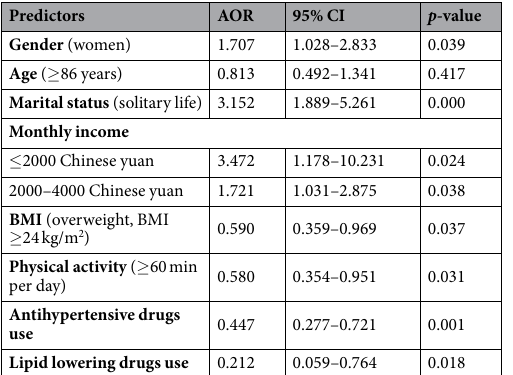
Table 2. Adjusted odds ratio for the risk of cognitive impairment. Multiple logistic regression analysis estimated the risk of cognitive impairment associated with potentially independent risk factors. The reference groups for comparison were men, age ≤ 85 years, non-solitary life, monthly income > 4000 Chinese yuan, BMI < 24, physical activity < 60 minutes per day, no use of antihypertensive drugs, and no use of lipid lowering drugs, respectively.